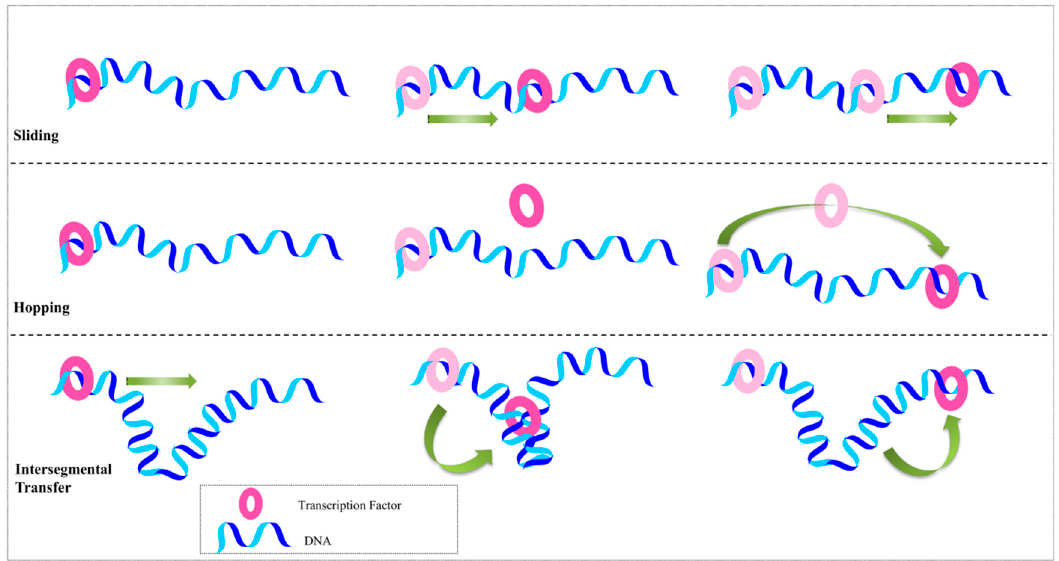
Figure 1. Protein-DNA recognition mechanisms. The main three protein-DNA recognition mechanisms are shown. When the transcription factor (pink ring) moves from one site to another by means of sliding along the DNA and is transferred from one base pair to another without dissociating from the DNA, this mechanism is called sliding (top). Hopping occurs when the transcription factor moves on the DNA by dissociating from one site and re-associating with another site (center). Intersegmental transfer describes the mechanism by which the transcription factor gets transferred through DNA bending or the formation of a DNA loop, resulting in the protein being bound transiently to both sides and subsequently moving from on site to the other (bottom).